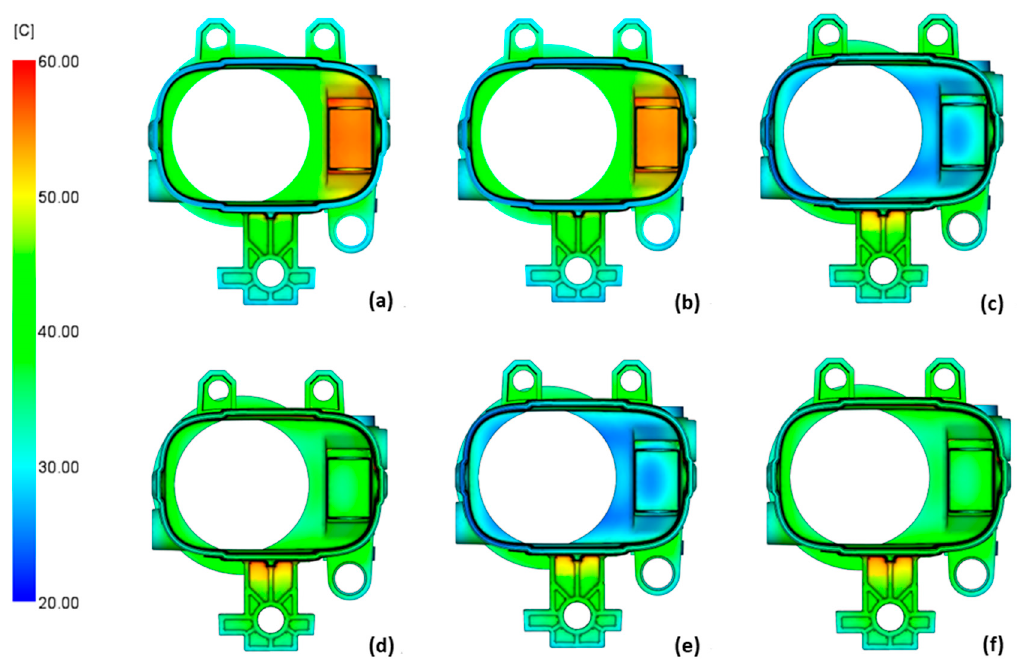
Figure 9. Product temperature results for conventionally cooled case 3 ( a ) and case 21 ( b ) and for the conformally cooled case 19 ( c ), case 20 ( d ), case 23 ( e ), and case 24 ( f ).